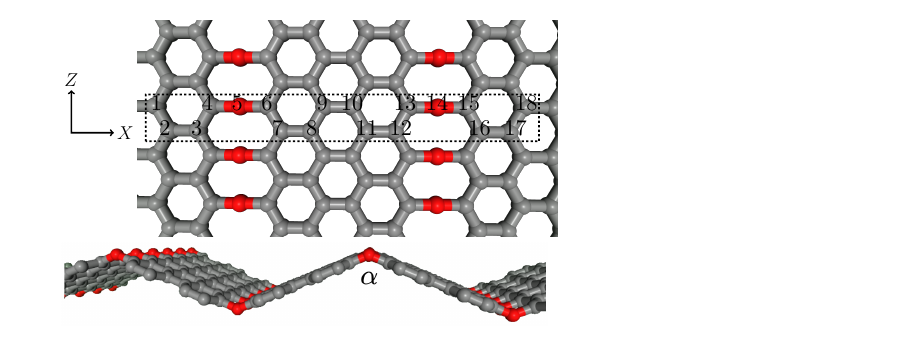
Figure 1. ( Top ) GO structure before structural optimization. The unit cell is shown in between dashed lines. The unit cell’s length along the X -direction defines the lattice constant, a lat . ( Bottom ) Side view of the optimized GO structure using DFT. Gray (red) balls represent carbon (oxygen)